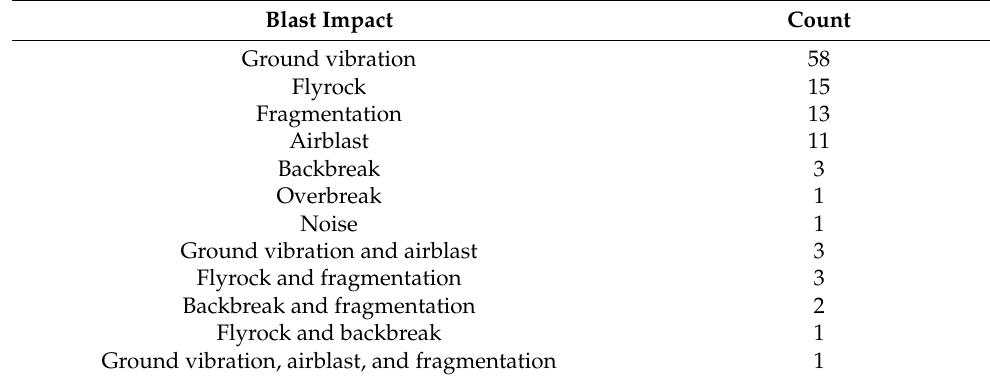
Table 2. Review statistics of blast-induced impacts predicted using machine